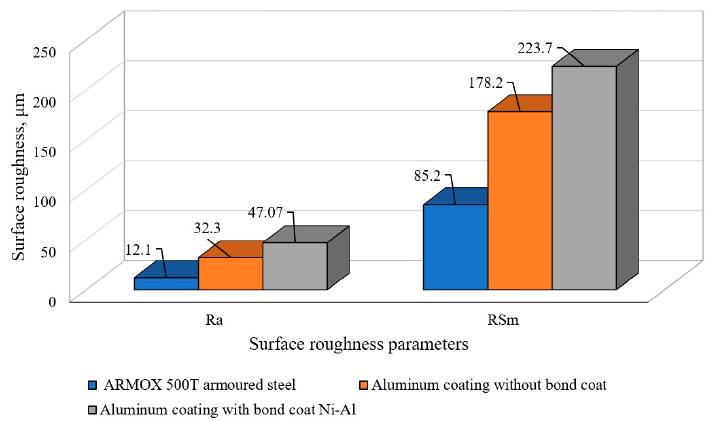
Figure 6. Surface roughness changes for Armox 500 T steel, 01T grade wire arc-sprayed aluminum without buffering subcoating, and buffered subcoating with 75B BondArc grade wire.